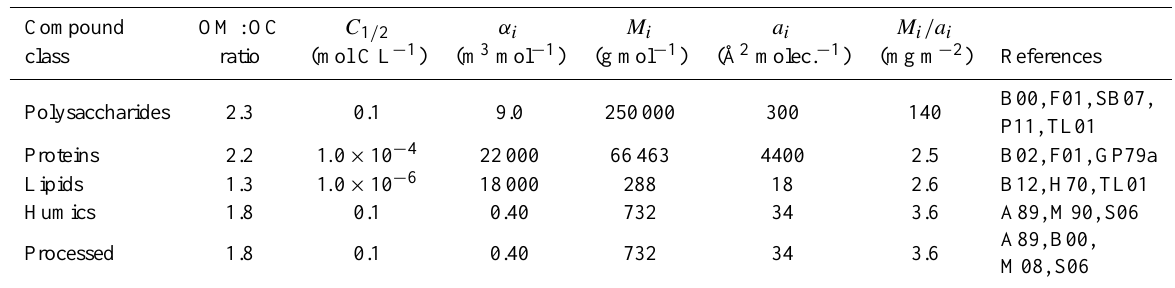
Table 2. Coefficients used to calculate box-model and global organic enrichment (BASE case). Values are derived from model compounds as described in Table 1: lysozyme, natural alginate, stearic acid, fulvic acid. Compound